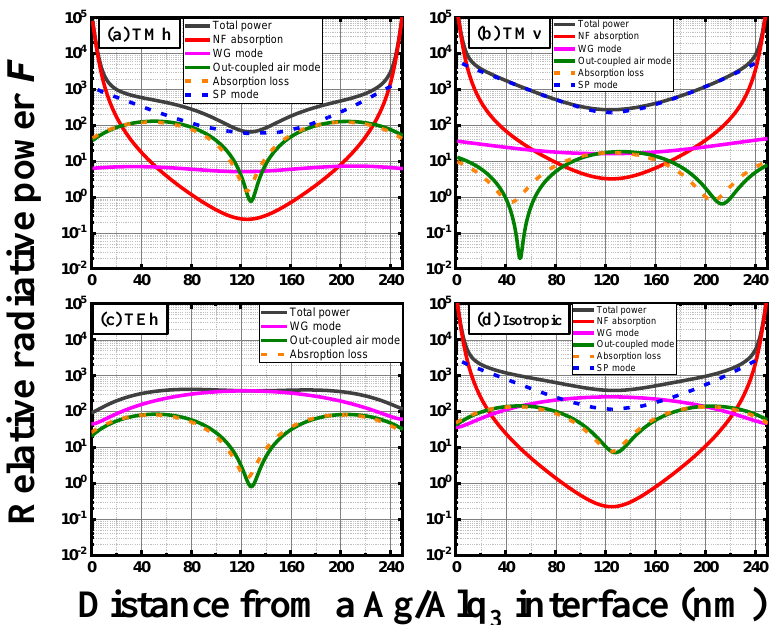
Figure 5. Calculated relative radiative powers of all the optical modes as a function of the dipole position in the EML for ( a ) a horizontally oriented dipole radiating TM-polarized light (TMh), ( b ) a vertically oriented dipole radiating TM-polarized light (TMv), ( c ) a horizontally oriented dipole radiating TE-polarized light (TEh), and ( d ) an isotropically oriented dipole. For the horizontally oriented dipole radiating TE-polarized light, the relative radiated powers of the SP mode and the NF absorption are not included because they cannot be excited by the horizontally oriented dipole in the TE-polarized light.